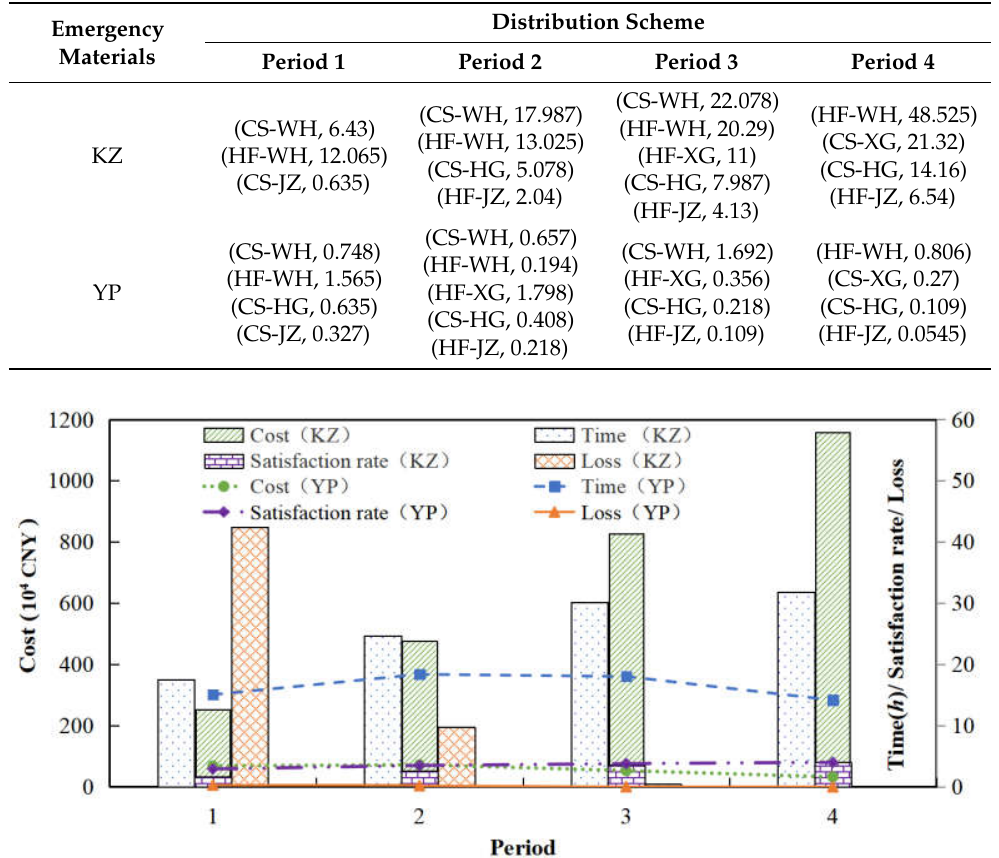
Table 9. Multi-period distribution scheme of emergency materials based on balance-criterion.